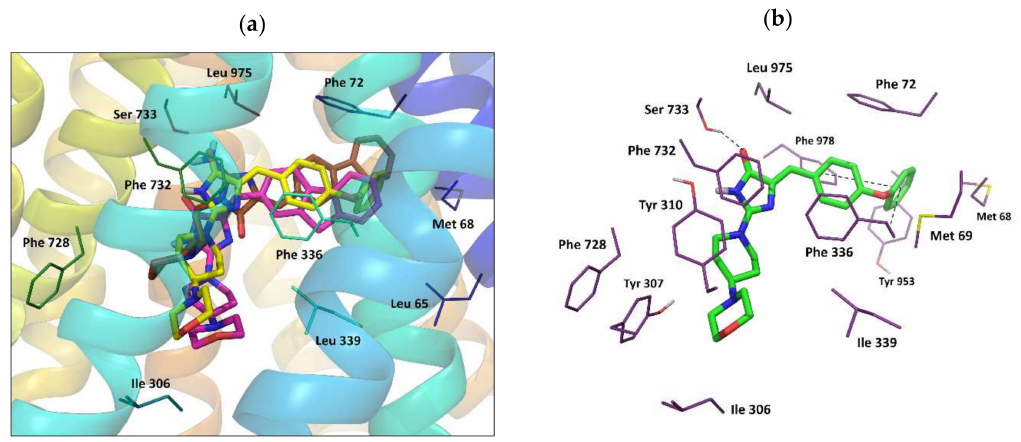
Figure 6. ( a ) Binding mode of compounds 11 , 18 , and 12 adopting docking pose 2; ( b ) molecular interactions for the best docking pose 2 represented by compound 11